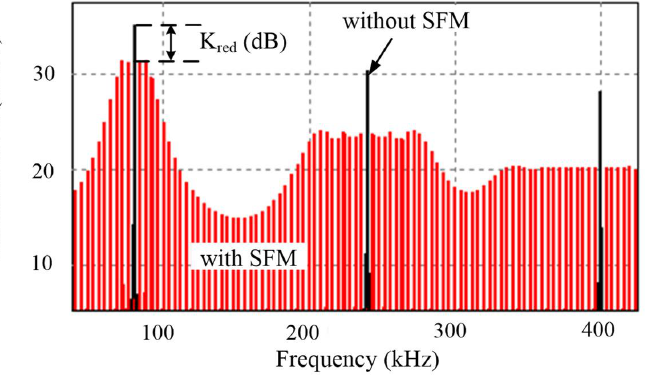
Figure 2. Simulated square control signal waveform with periodic SFM. Parameters: central switching frequency f 0 = 85 kHz; Δ f peak = 10 kHz; f m = 17 kHz. Modulation waveform is ramp.